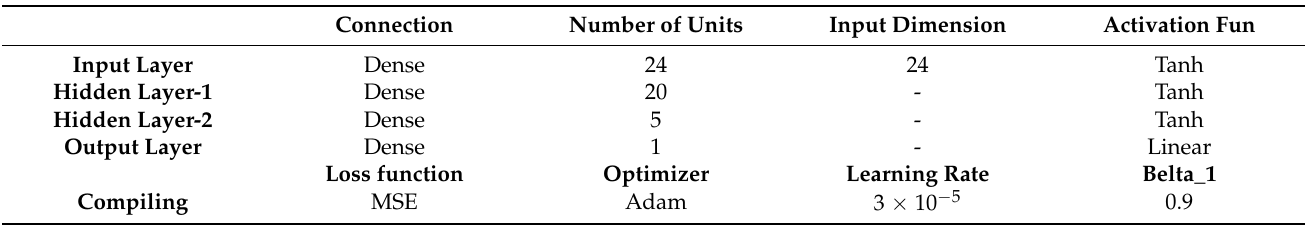
Table 4. MLP model setup.